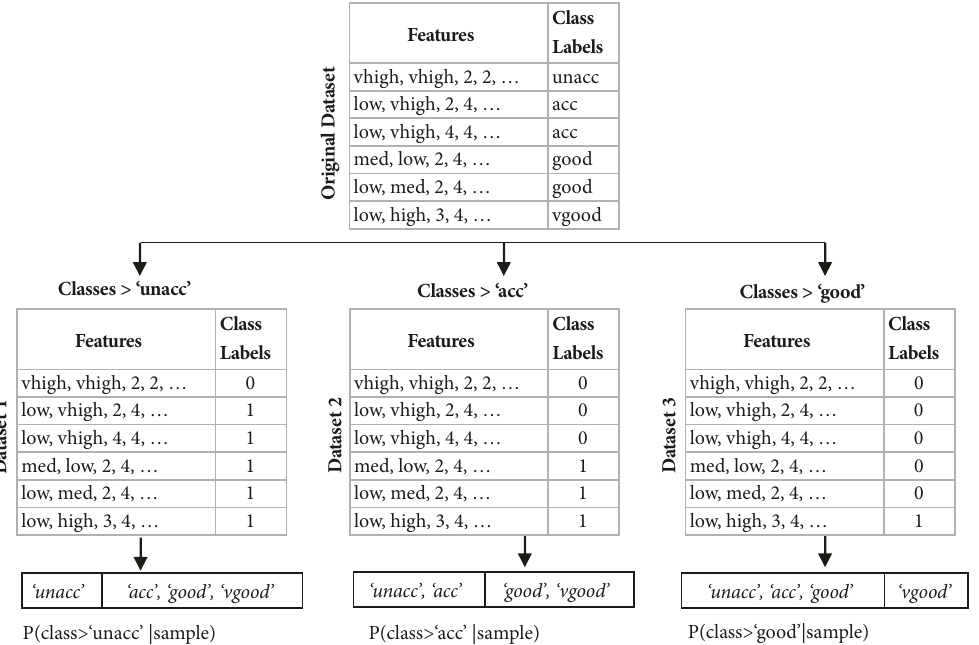
Figure 2: Application of ordinal class classifier algorithm on “car evaluation”